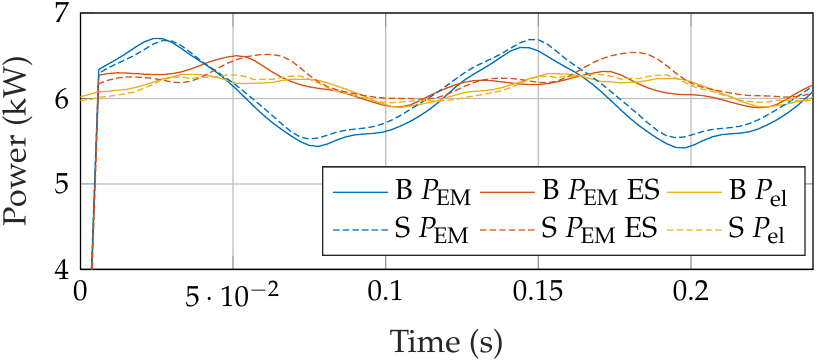
Figure 18. The lossless electrical power without the extended stator (ES) and the electromagnetic power (associated with the detent force) with and without ES at current density of 2A/mm 2 RMS.